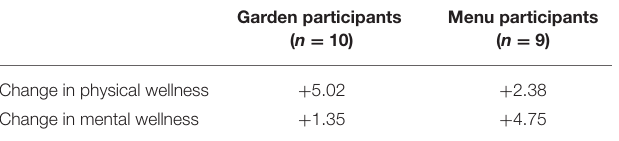
TABLE 1 | Average change in participant wellness in each condition, on the 0-100 point scale of the SF12v2 quality of life/wellbeing survey. For an individual, a change of 5 points or more is generally considered clinically